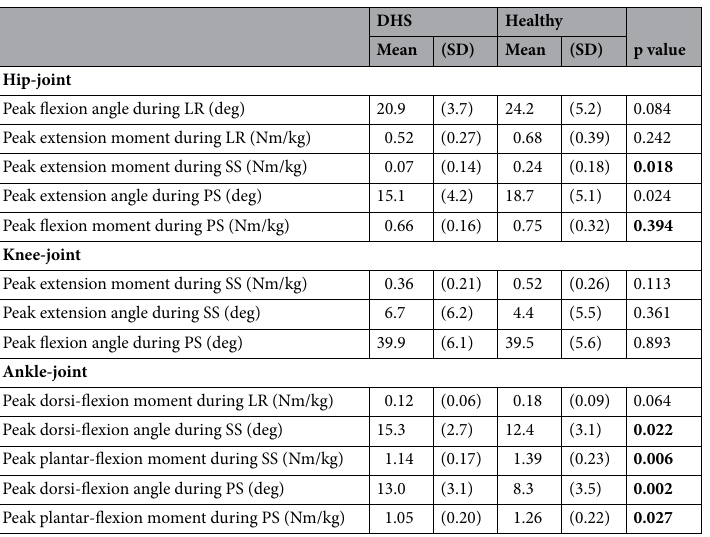
Table 4. Comparison of lower limb kinetic and kinematic parameters between the two groups. Bold figures indicate statistically significant p < 0.05. DHS Dropped head syndrome, LR loading response, SS single stance, PS pre-swing, SW swing.